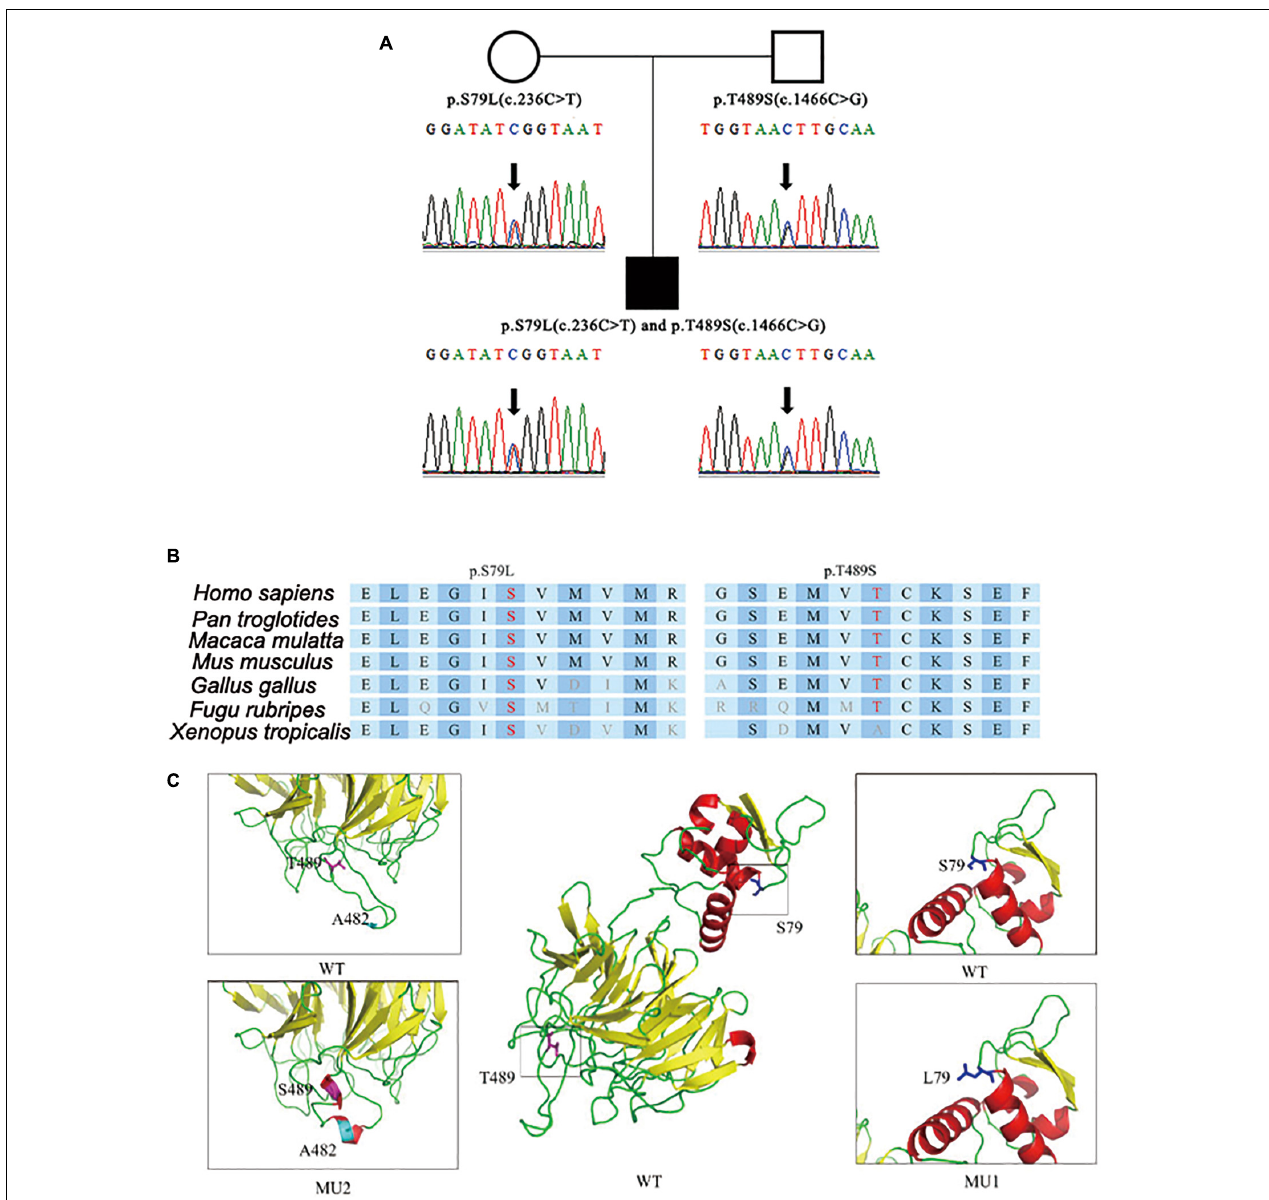
FIGURE 1 | Identification of compound heterozygous mutations in the GAN gene. (A) Compound heterozygous mutations p.S79L (c.236C > T) and p.T489S (c.1466C > G) were identified in the patient’s copies of the GAN gene. (B) The location of the mutations with respect to the topological model of the GAN polypeptide. (C) Predicted crystal structures of wild-type and mutant GAN proteins. The proposed locations of the two mutations are shown in blue and pink. This model is based on template c4yy8B and covered 375 residues (32–575). The red coloring indicates helices, the yellow coloring indicates β -sheets, and the green coloring indicates